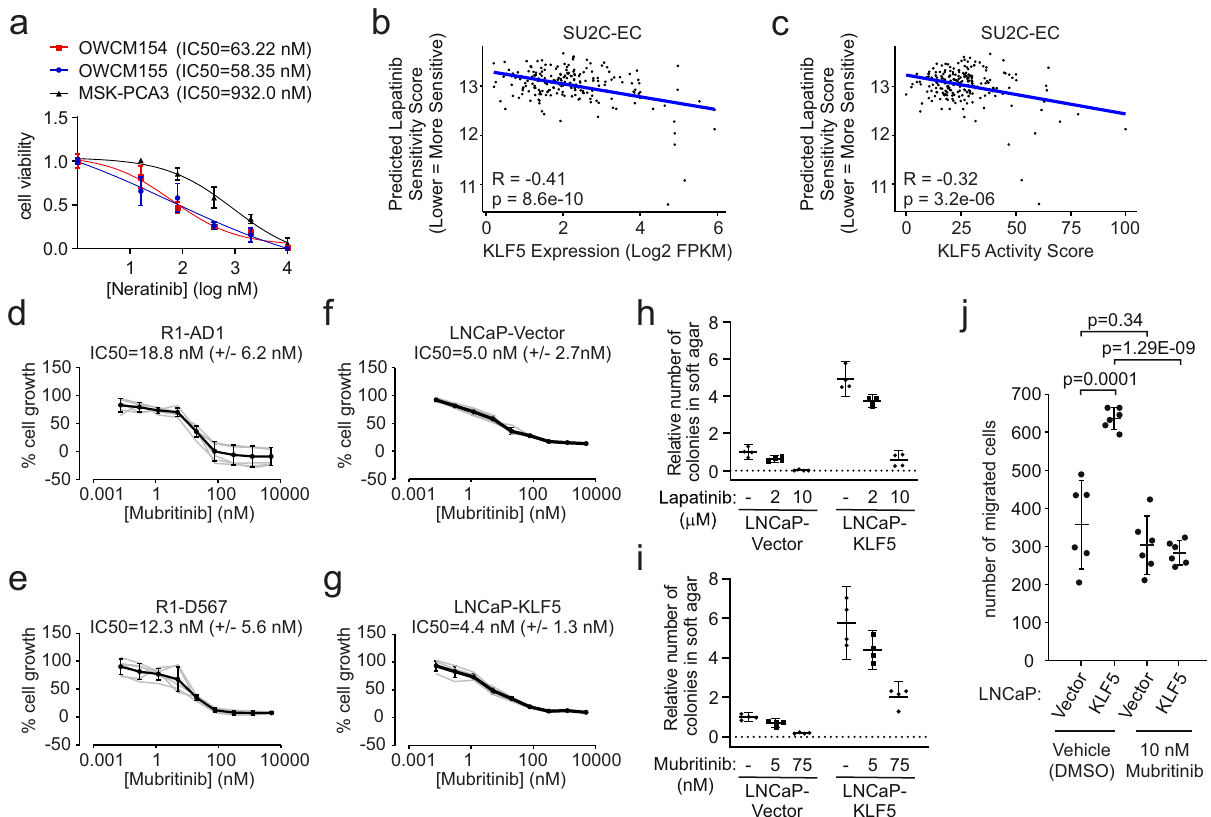
Fig. 8 Targeting ERBB2 inhibits oncogenic effects of KLF5. a Viability assays of patient-derived organoids developed from neuroendocrine CRPC (OWCM154 and 155) or CRPC adenocarcinoma (MSK-PCA3) treated with neratinib. Data are mean ±95% CI from three independent experiments in biological triplicate ( n = 9). b , Lapatinib sensitivity scores predicted using ridge regression models trained on high-throughput cancer cell line drug screens in metastatic CRPC tumors (SU2C-EC study), plotted vs. KLF5 expression (FPKM = fragments per kb per million fragments mapped). Pearson correlation coef fi cients (R) and 2-tailed p -values for r ≠ 0 are shown. c Lapatinib sensitivity scores as in b plotted vs. KLF5 activity score. d – g 2-dimensional